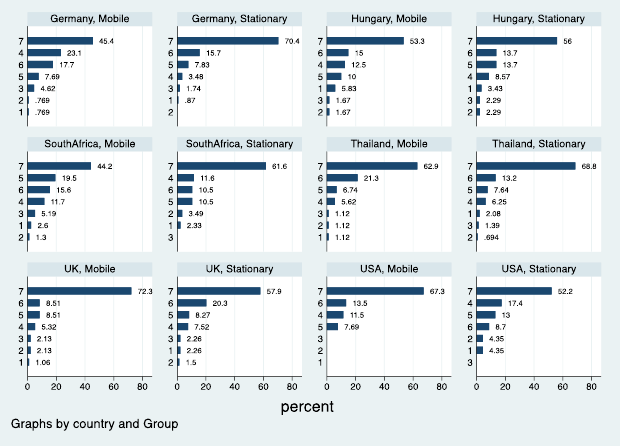
Figure 2: Survey responses in relative numbers to the statement “Showing loot box probabilities makes me spend less on In- App / In-Game purchases” (own